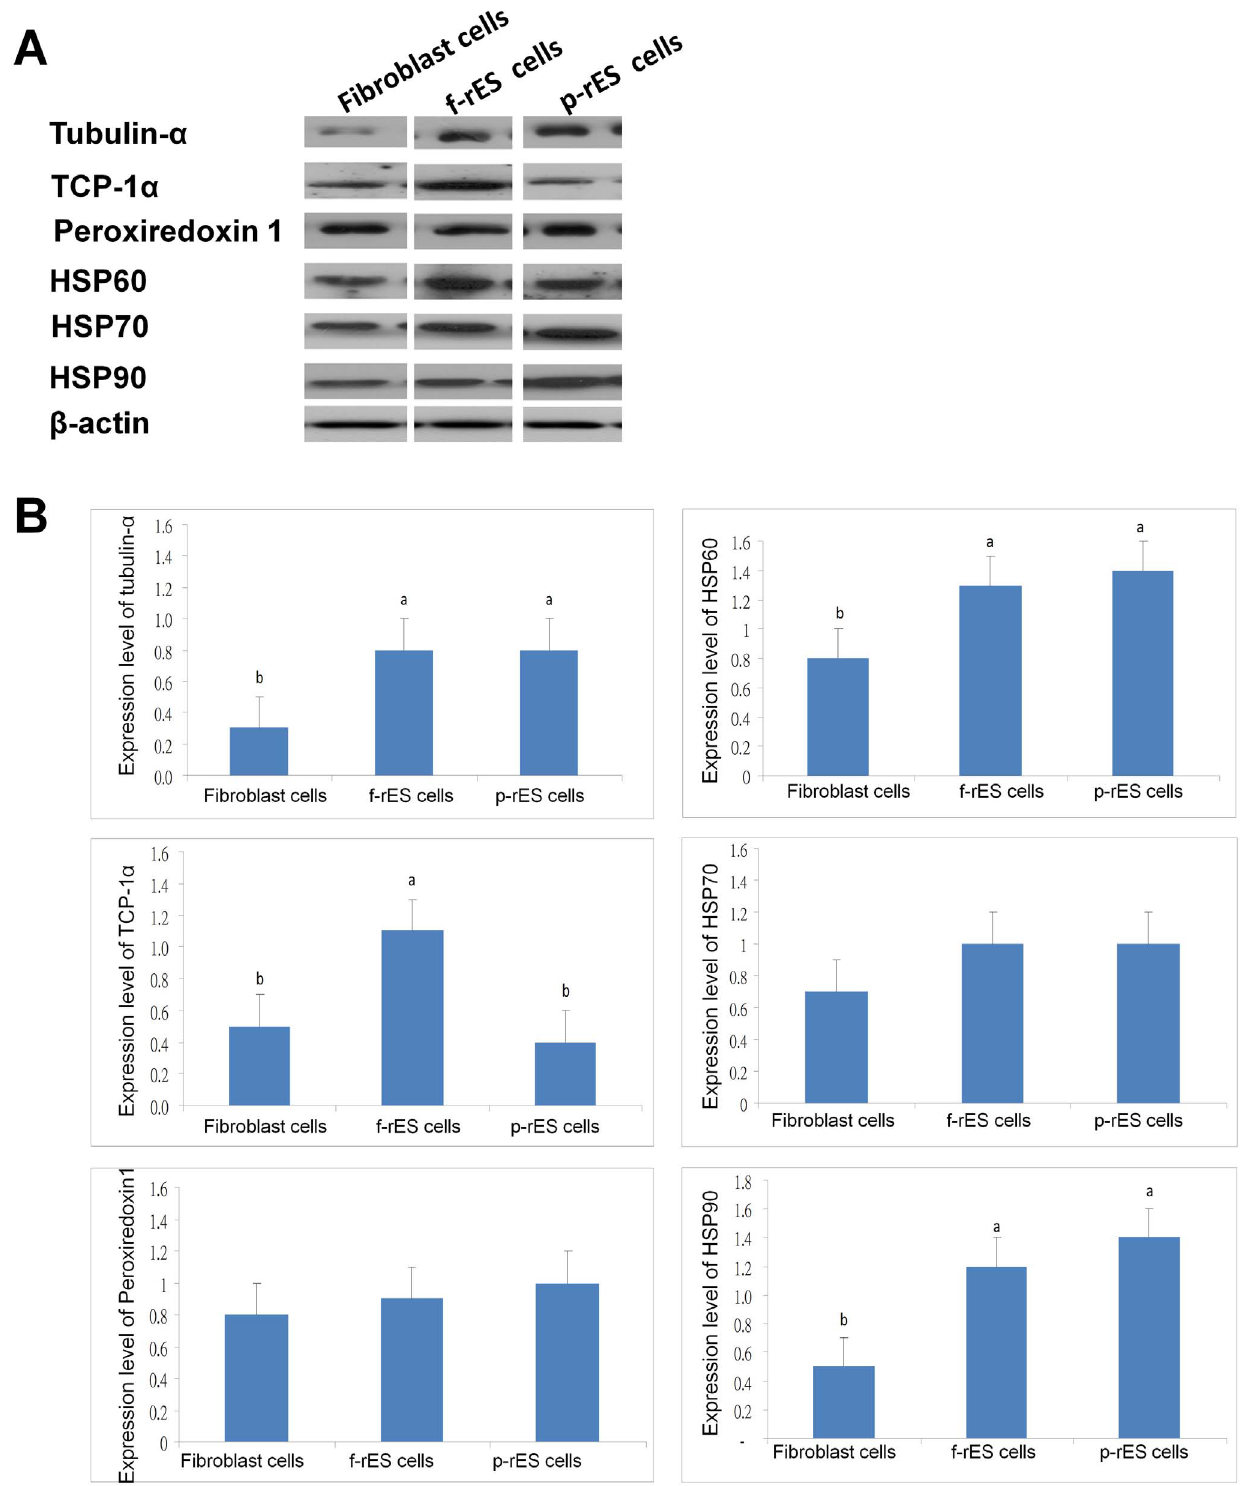
Figure 7. Western blot analysis of total protein extracts from fibroblast, f-rES and p-rES cells. (A) The proteins of interest were analyzed using 50 m g of protein extracts from fibroblast, f-rES and p-rES cells for SDS-PAGE followed by Western blotting. Membranes were hybridized with antibodies against a -tubulin, peroxiredoxin 1, TCP-1 a , HSP60, HSP70, and HSP90, using b -actin as a loading control. The protein bands in the blots were quantified by using an Image J software, and the quantitative data is shown in (B). Three replicates were performed in each cell type, and bars without the same alphabetic letters differ ( p , 0.05 ).